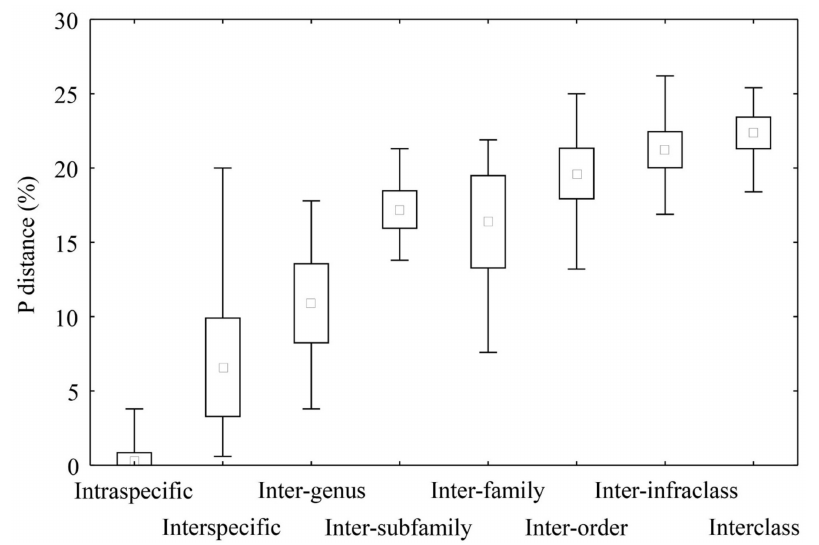
Figure 3. Genetic distance ranges among inter-rank categories. The middle point, box, and whiskers represent the mean, mean ± standard deviation, and total range,